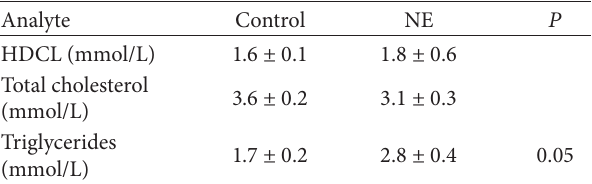
Table 3: Lipids analysis in NE cases with high bleeding score.